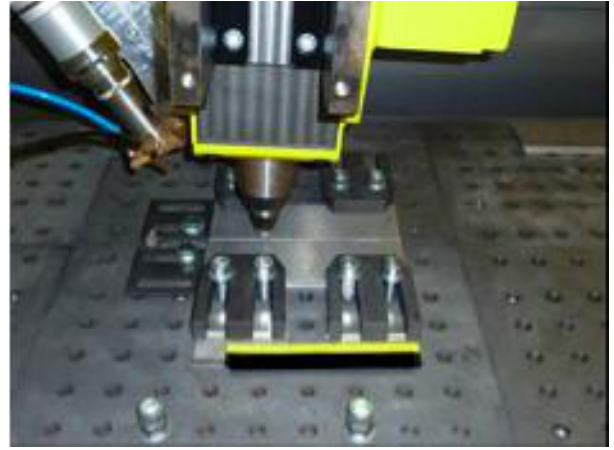
Figure 1. Machine set-up and clamping system.